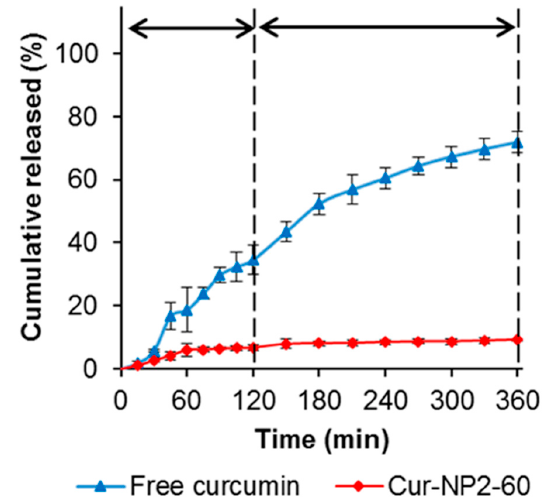
Figure 6. Controlled release of curcumin from nanoparticles under simulated gastrointestinal pH conditions.